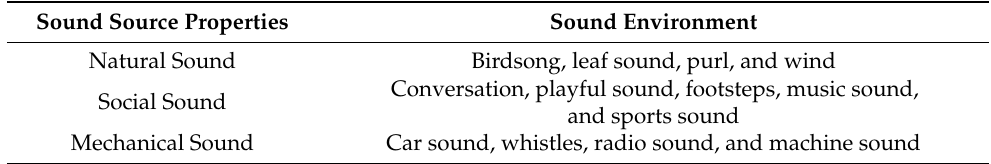
Table 2. Main types of acoustic environment in the park.